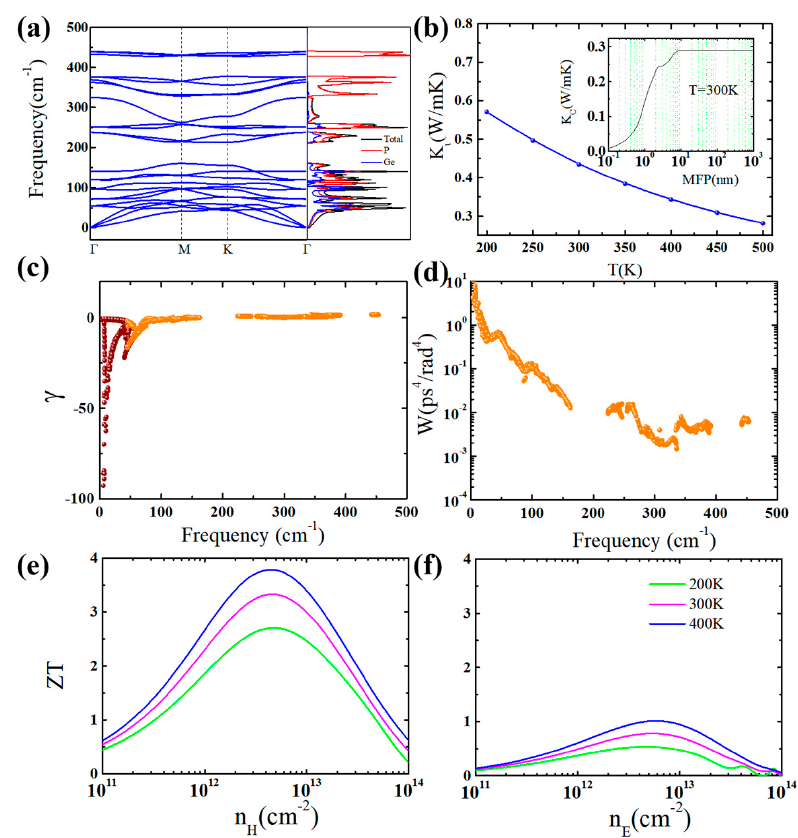
Figure 3. The phonon dispersion ( a ), the temperature-dependent lattice thermal conductivity ( b ), the frequency-dependent Grüneisen parameter γ ( c ) and three-phonon scattering phase space W ( d ) at 300 K, and the p -type ( e ) and n -type ( f ) figure of merit ZT with the change of carrier concentration and temperature for monolayer GeP 3 . The inset in ( b ) shows the cumulative lattice thermal conductivity as a function of phonon mean-free-path (MFP) at 300 K.